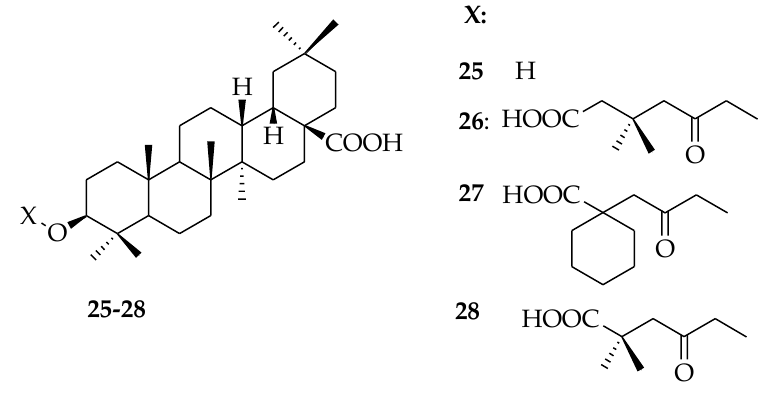
Figure 7. Oleanolic derivatives with anti-HIV activity.